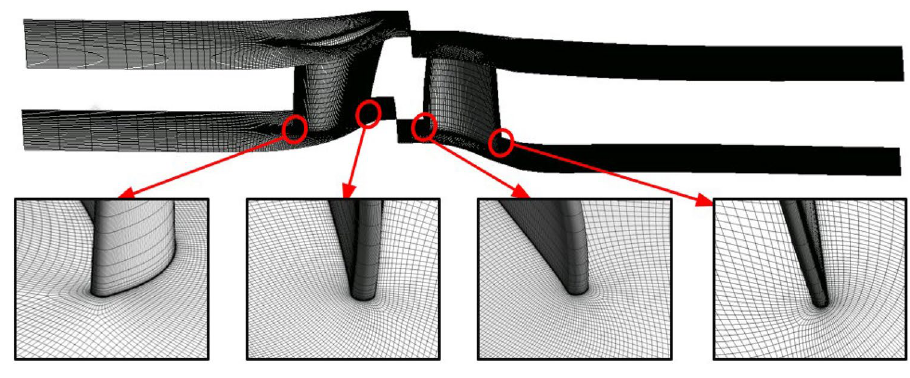
Fig. 13 Computational domain and mesh for OPT